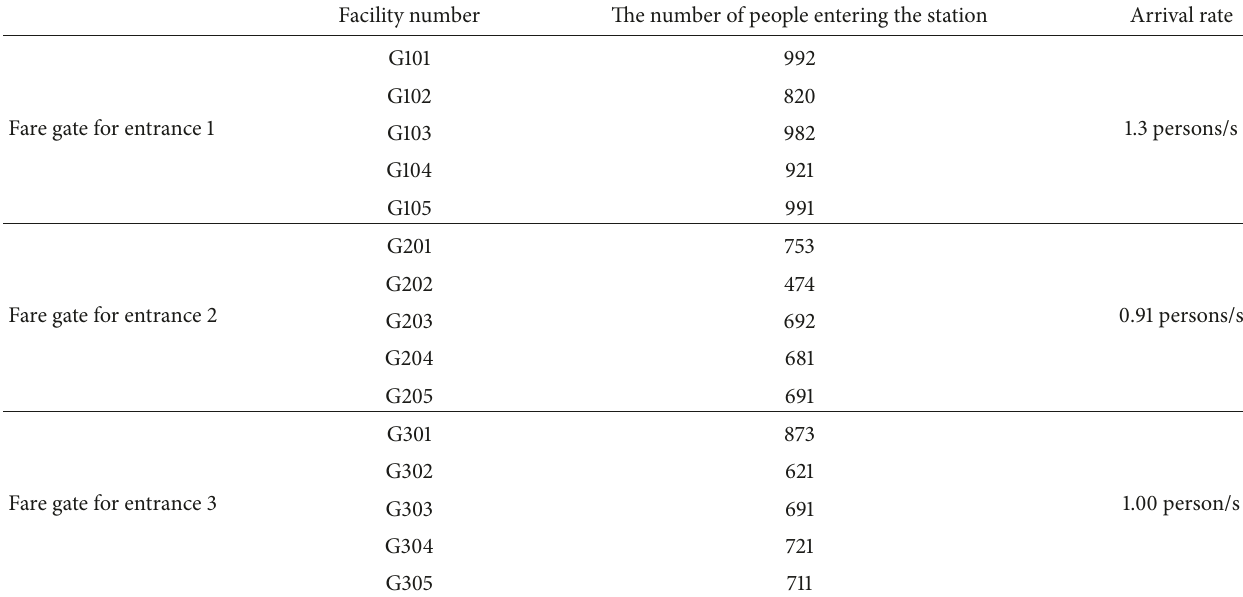
Table 1: The arrival rate of passengers entering QiBao station in peak hours.